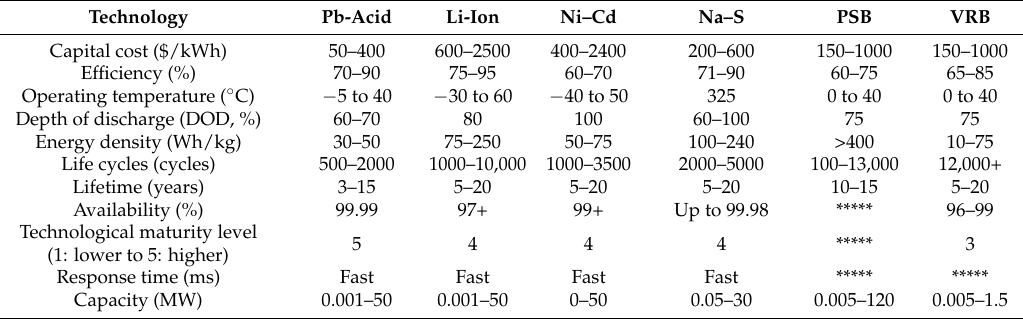
Table 1. Battery technologies in renewable energy systems (RES). Pb-Acid: lead-acid; Li-Ion: lithium- ion; Ni–Cd: nickel-cadmium; Na–S: sodium-sulfur; PSB: Polysulphide–bromide flow battery; VRB: vanadium redox flow battery.